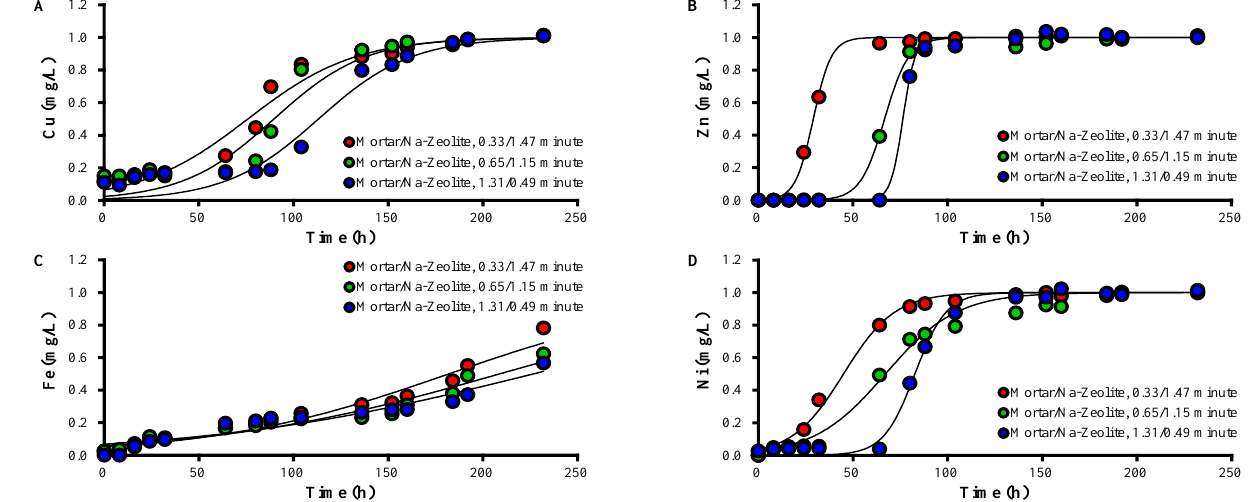
Figure 4. Variations over time in the concentration of ( A ) Cu 2+ , ( B ) Zn 2+ , ( C ) Fe 3+ , and ( D ) Ni 2+ ions in the effluent collected after the mortar layer from the dual system, in mg/L, for different ratios of EBCTs; the working temperature is 20.5 ◦